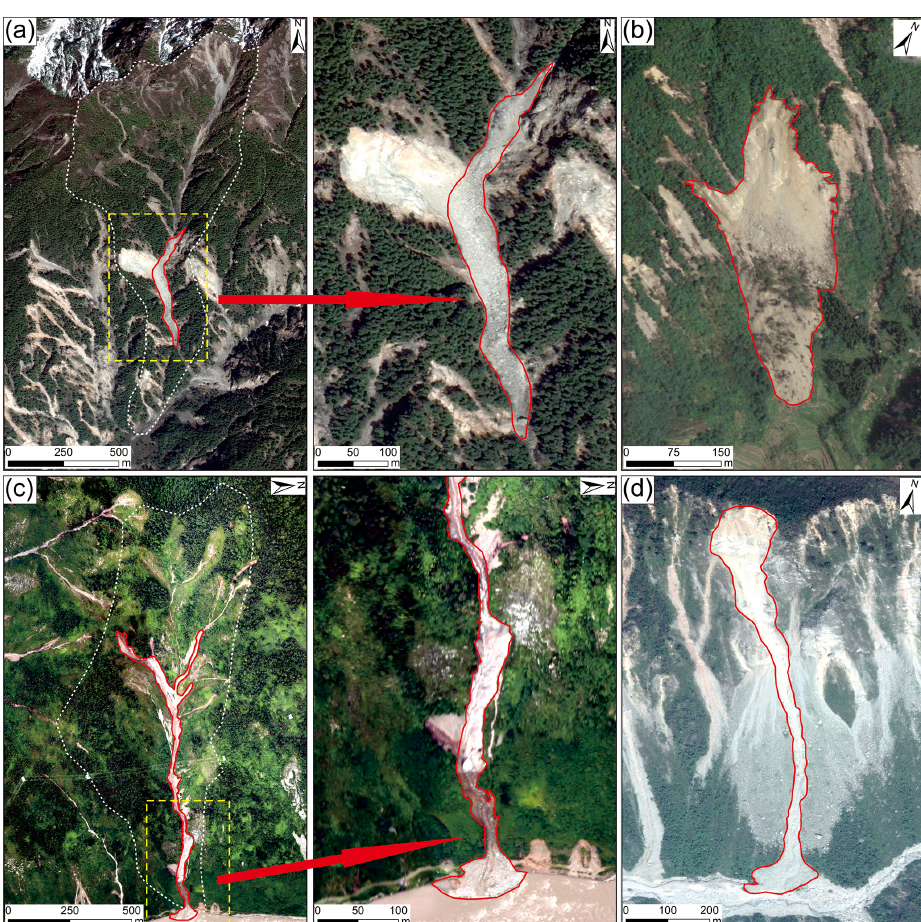
Figure 4. Types of landslides and deposits mapped in the inventory: channel deposit (a) , slide (b) , debris flow in a channel (c) and debris flow on a hillslope (d)